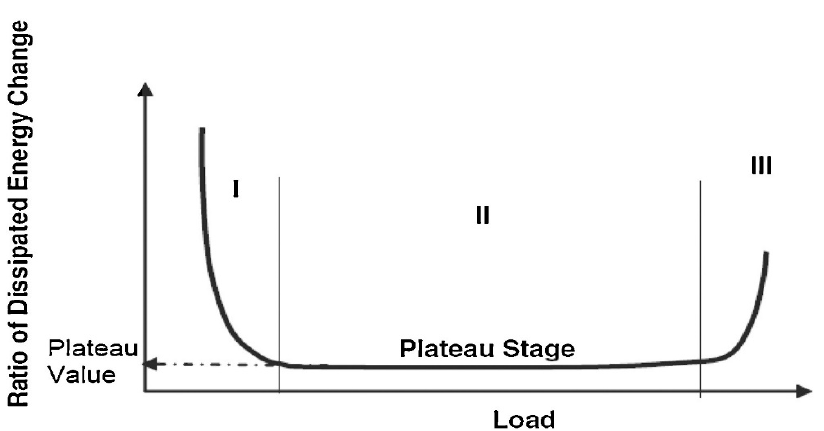
Figure 5. Typical dissipated energy ratio plot with the three characteristic zones [5].